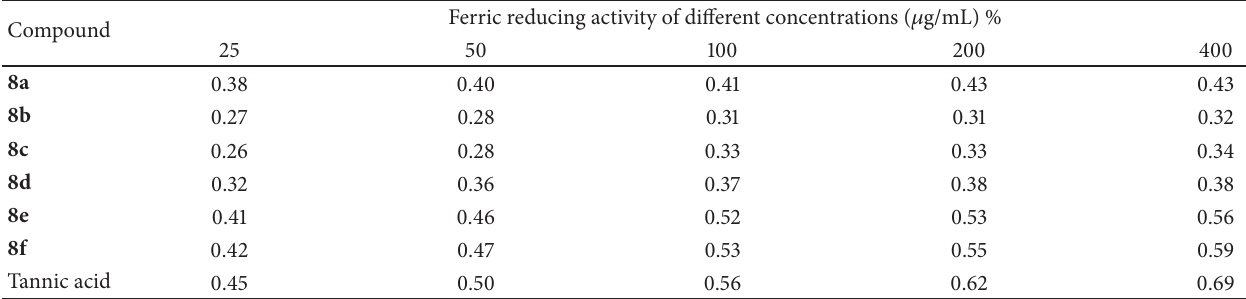
Table 4: Ferric reducing activity of compounds 8(a–f)